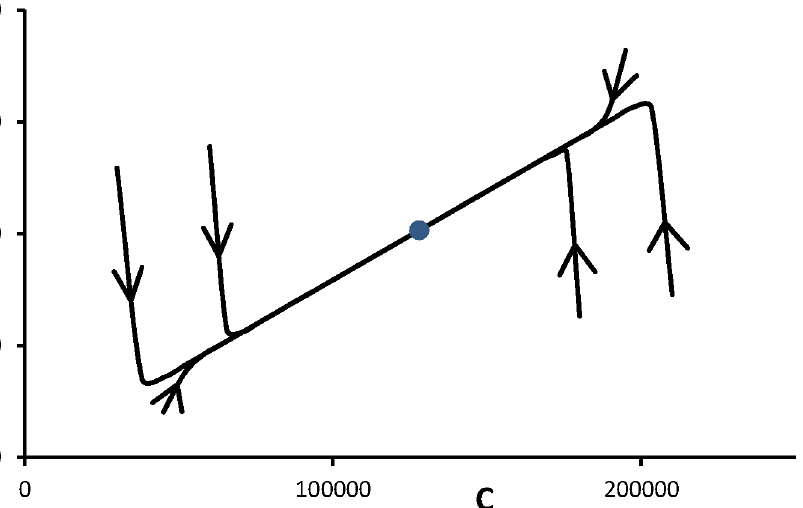
Figure 2. Dynamics of the system of differential equations (1abc) for the (constant) parameter values given in Table 1. It is noted that the two differential equations have different time scales. Eq.(1c) has a fast time scale meaning that in the beginning L rapidly changes its value so that the system reaches a quasi-stationary state satisfying b C { c L ~ 0 : Next along this line the equilibrium ( C , L ) is slowly approached in a way prescribed by Eq.(1a) with constraint